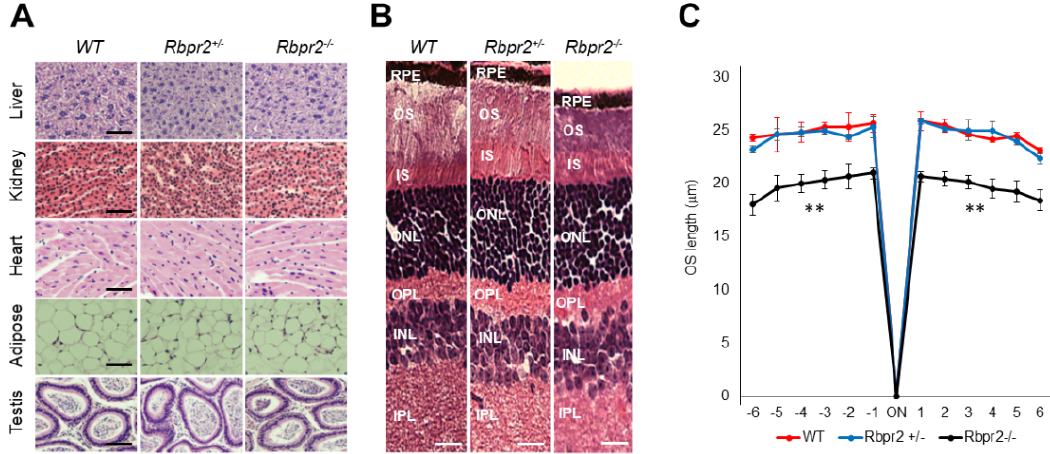
Figure 4. Rbpr2 − / − mice on vitamin A-deficient diets show retinal phenotypes. ( A , B ) Representative tissue histology and staining of liver, heart, adipose, testis, retina (H&E stain), and kidney of 12-week old wild-type (WT), heterozygous Rbpr2 +/ − , and homozygous Rbpr2 − / − (KO) mice on vitamin A-deficient diets. ( C ) Quantification of photoreceptor outer segment (OS) lengths from H&E sections of 12-week old WT, heterozygous Rbpr2 +/ − , and homozygous Rbpr2 − / − (KO) mice using “spider graph” morphometry. The OS lengths from H&E sections through the optic nerve (ON; 0 µ m distance from the optic nerve and starting point) were measured at 12 locations around the retina, six each in the superior and inferior hemispheres, each equally at approximately 150 µ m distances. RPE, retinal pigmented epithelium; OS, outer segments; IS, inner segments; ONL, outer nuclear layer; INL, inner nuclear layer; IPL, inner plexiform layer. Scale bar = 50 µ m ( A ); 100 µ m ( B ). ** p < 0.005; Rbpr2 − / − mice vs. controls.